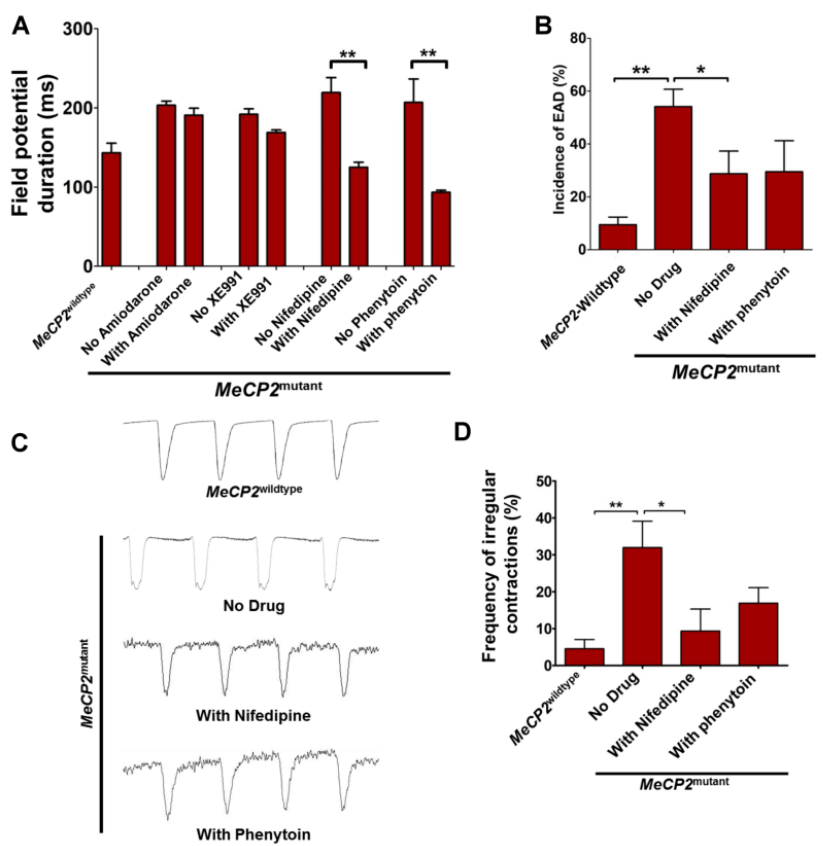
Figure 5. Calcium and sodium channel blockers ameliorate the abnormal cardiac phenotypes in car- diomyocytes expressing the MeCP2 mutant allele. ( A ) iPSC-CMs were treated with 1 µM amiodarone (anti-arrhythmic drug), 5 µM XE991 (KCNQ channel blocker channel blocker), 5 µM phenytoin (voltage-gated sodium channel blocker), or 0.5 µM nifedipine (L-type calcium channel blocker).